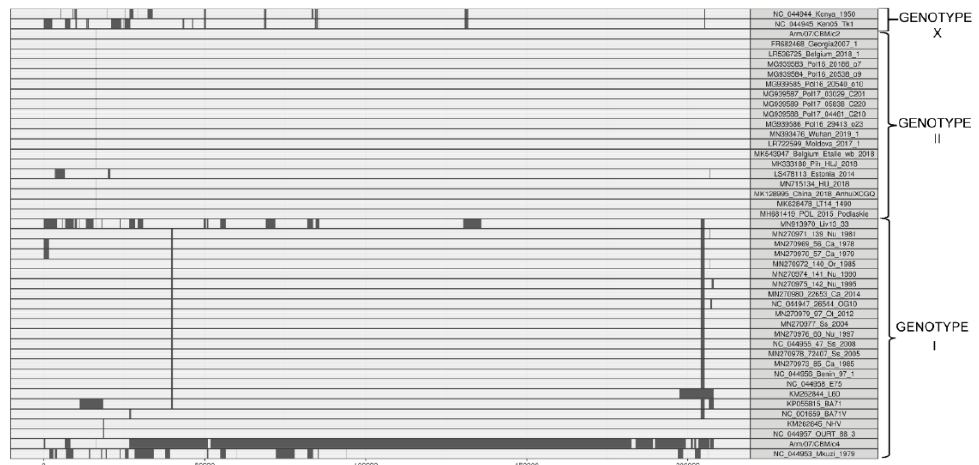
Figure 5. Recombination events inferred by RDP (Recombination Detection Program) in the ASFV genomes used for the phylogenetic tree construction.